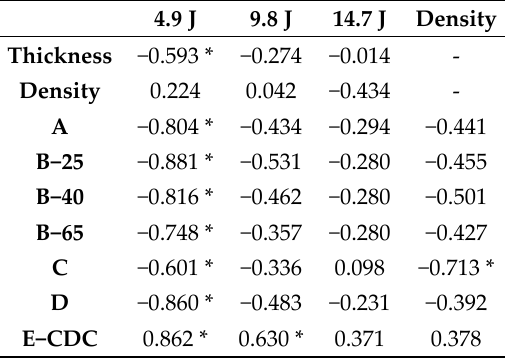
Table 3. Spearman’s (rho) Correlation Matrix.